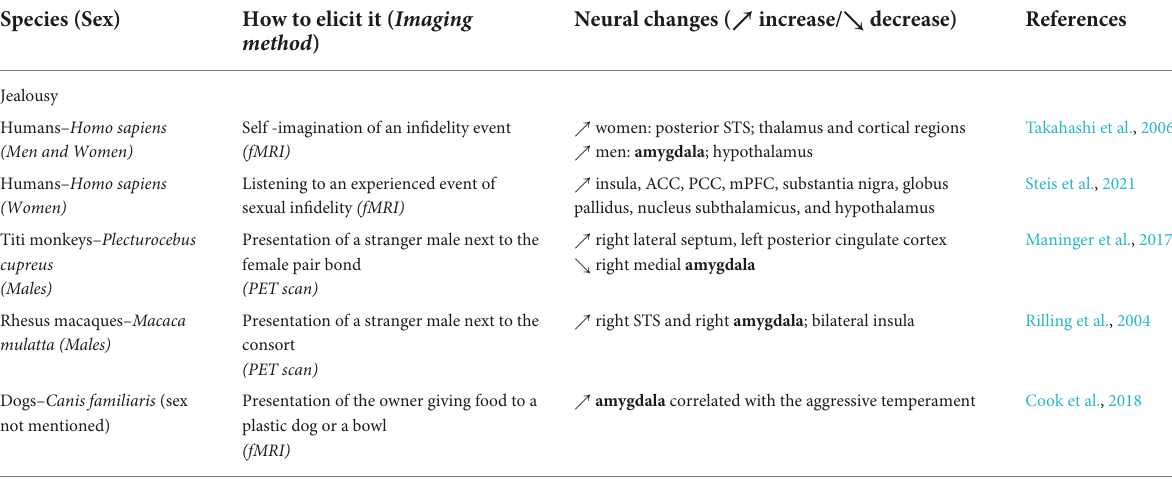
TABLE 4 Summary of the brain areas involved in the expression of jealousy across species. Species (Sex) How to elicit it ( Imaging Neural changes ( (cid:37) increase/ (cid:38) method )